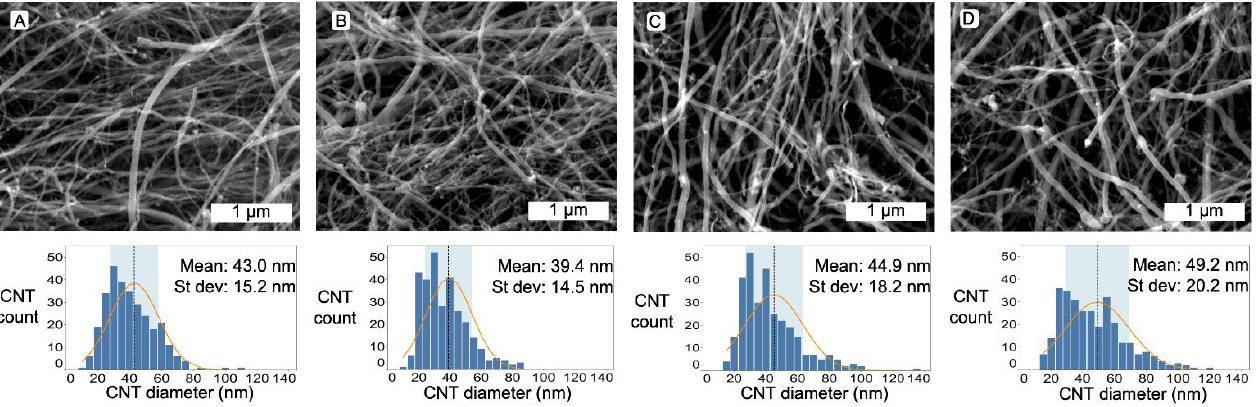
Figure 1. High resolution transmission electron microscope images showing ( A ) multiple walls and ( B ) the presence of internal catalyst particles in ( C ) long MWCNTs. ( D ) FFT analysis confirmed d(002) and d(004) line spacings. MWCNT lengths ( E ) reach over 10 μm in this case.